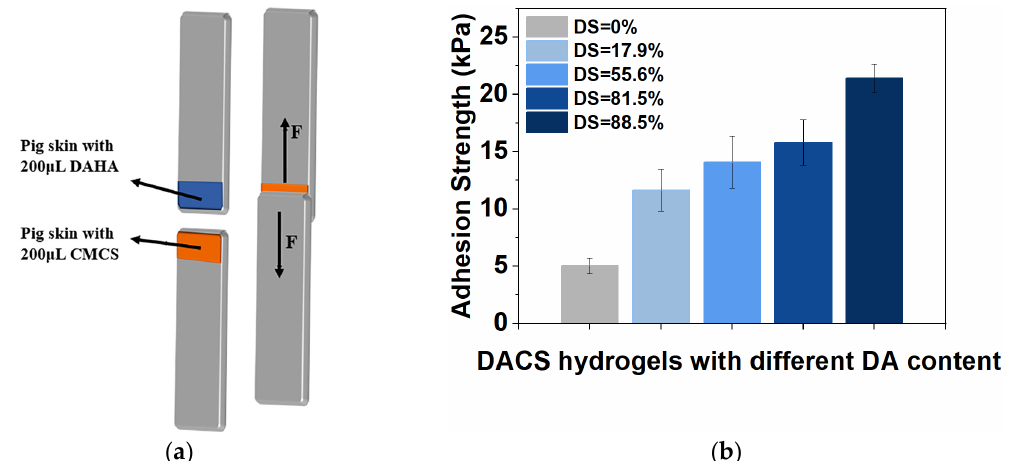
Figure 7. ( a ) The schematic diagram of lap-shear test of DACS hydrogels on porcine skin; ( b ) The average adhesion strength of DACS hydrogels with different DA content (17.9%, 55.6%, 81.5%, and 88.5%) on porcine skin tissue surfaces.